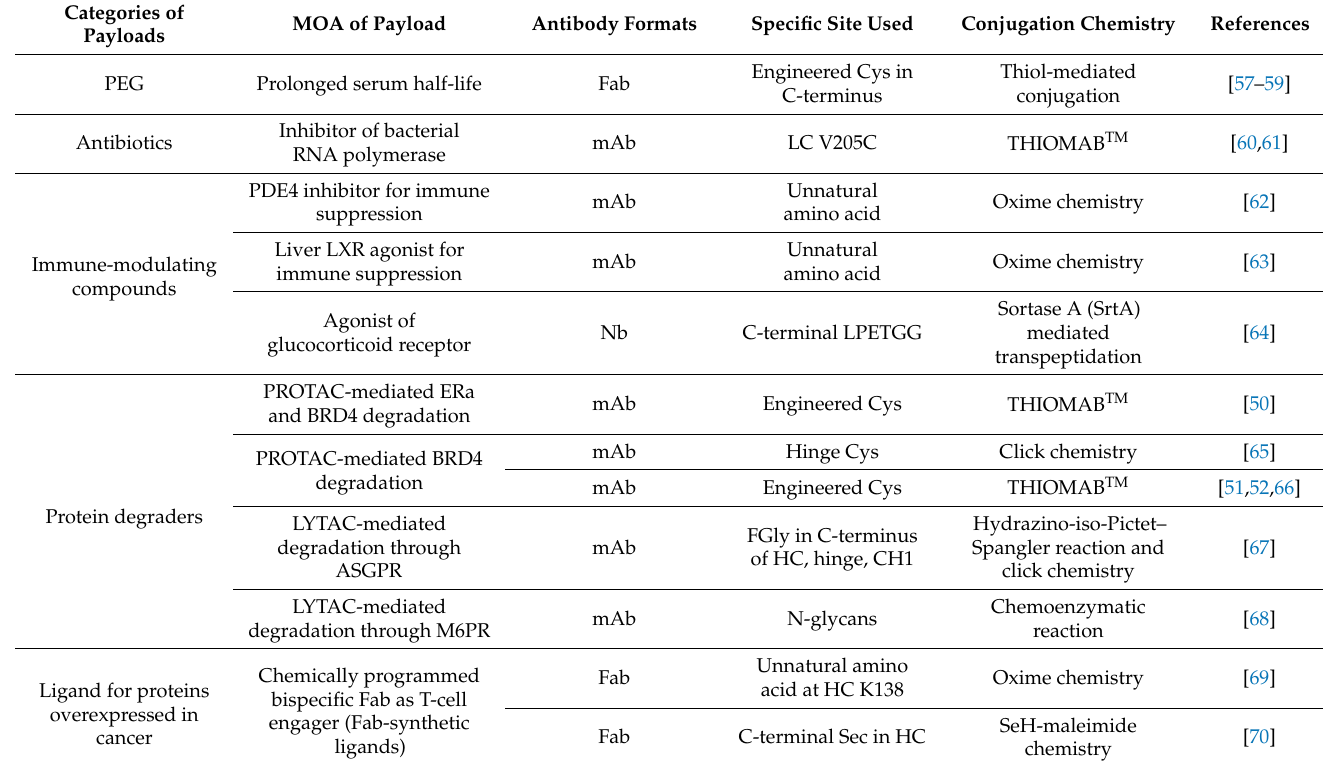
Table 2. Site-specific antibody conjugations with non-cytotoxic